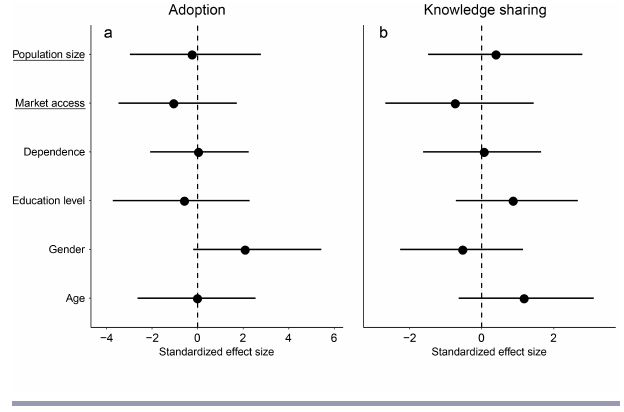
Fig. 4 . Differences in sea cucumber (a) first cooking duration; (b) salt curing duration; and (c) second cooking duration among trained (blue bars) and untrained (yellow bars) fishers across six harvested species groups: Bohadschia spp. (Boh), Actinopyga spp. (Act), teatfish (Teat), lollyfish and pinkfish (L & P), Thelenota spp. (The), and Stichopus spp. (Sti). Dashed lines indicate the minimum and maximum cooking durations considered appropriate for a particular species group. Salt curing was an optional processing step, with a recommended duration of between two and five